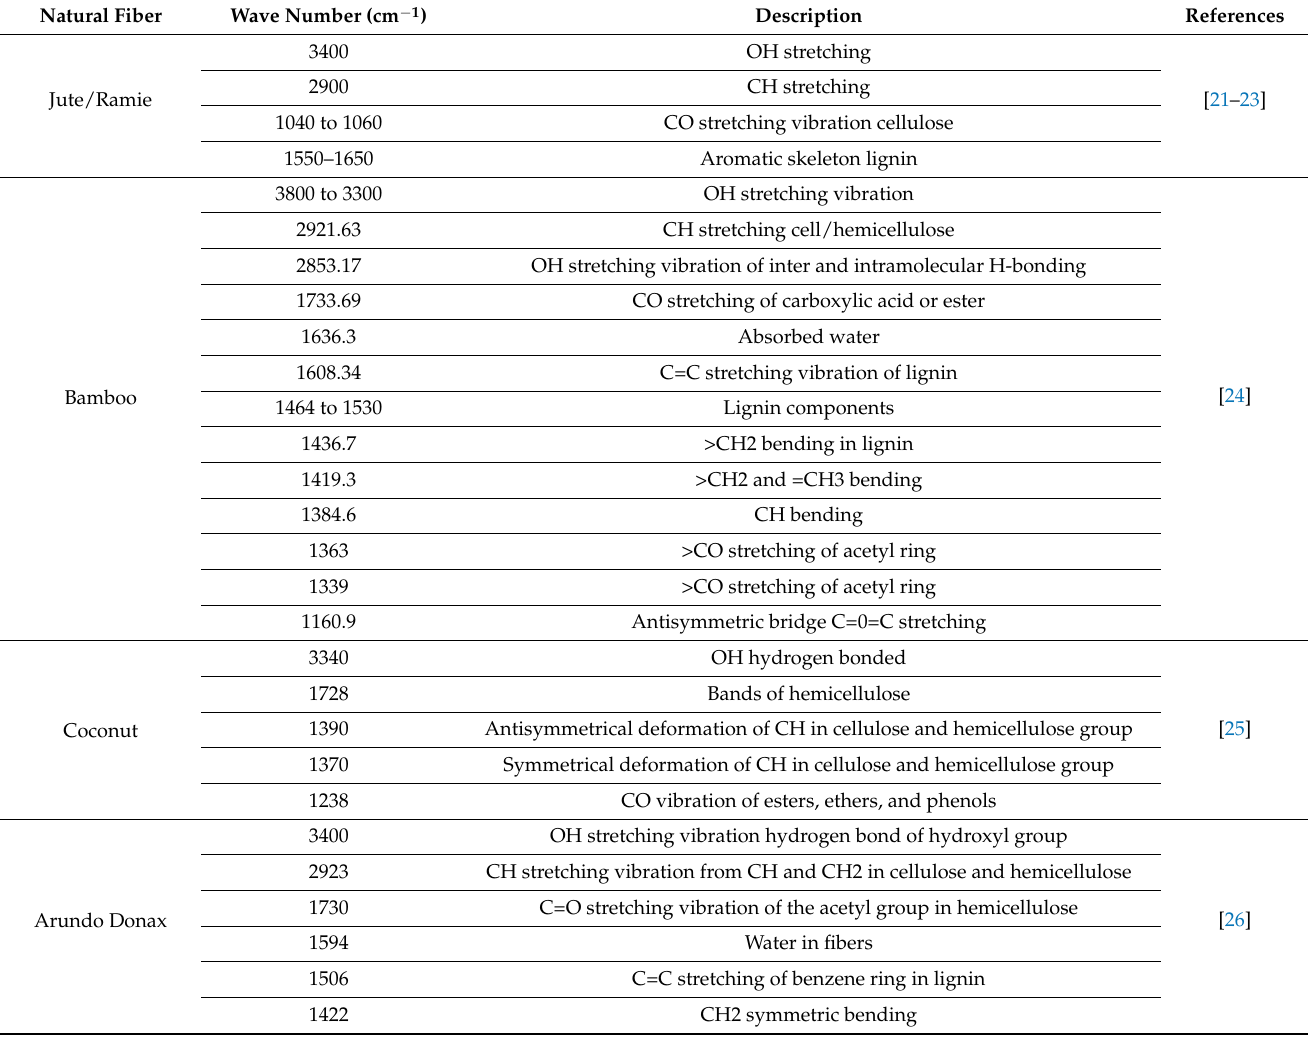
Table 1. Vibrational characteristic for natural fibers obtained via